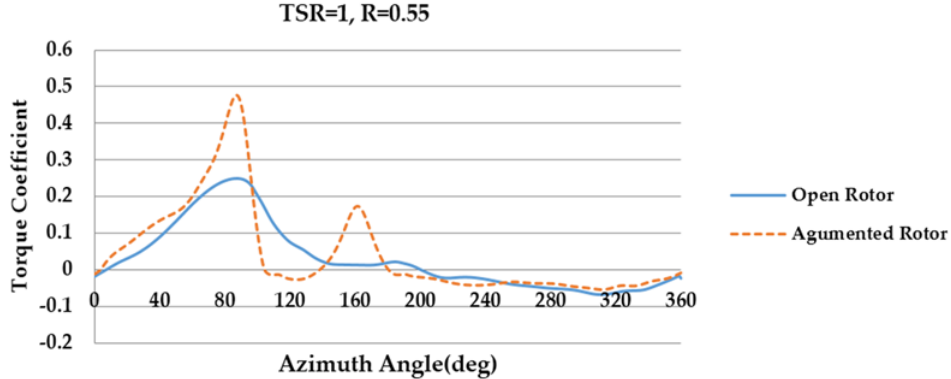
Figure 21. Torque coefficient versus azimuth angle for open and augmented rotor for TSR = 1, R shape ‐ ratio = 0.55.